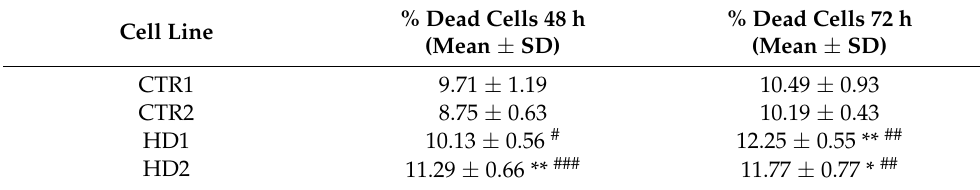
Table 6. Percentage of CTR1, CTR2, HD1 and HD2 dead fibroblasts at 48 and 72 h in basal conditions. Percentages of dead cells are shown as mean ± standard deviation (SD). * p < 0.05 and ** p < 0.01, compared with CTR1 (Two-way ANOVA, followed by uncorrected Fisher’s LSD for multiple com- parisons); # p < 0.05, ## p < 0.01 and ### p < 0.0001, compared with CTR2 (Two-way ANOVA, followed by uncorrected Fisher’s LSD for multiple